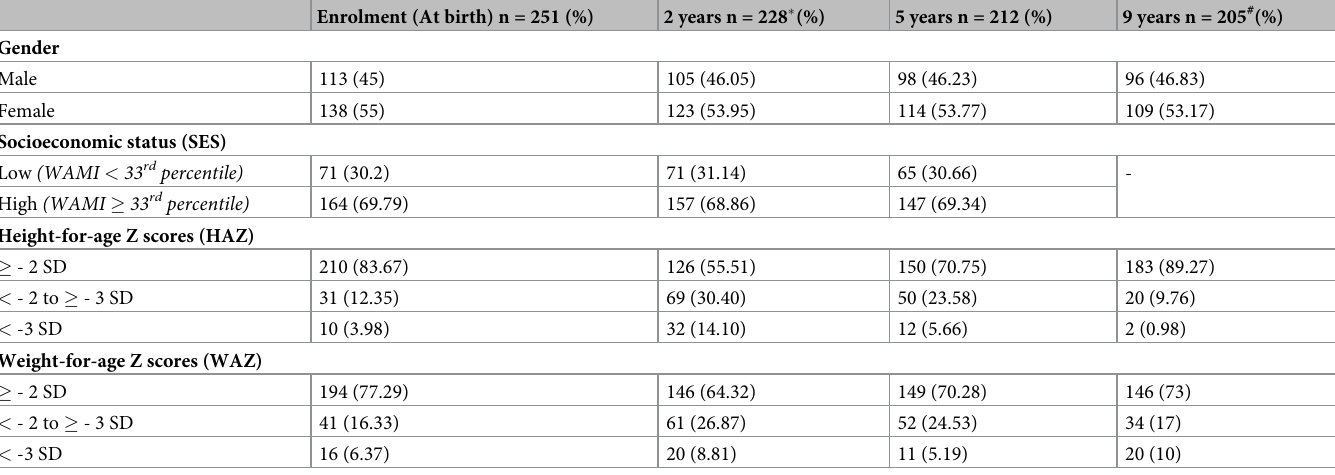
Table 1. Comparison of cohort characteristics at birth enrolment, years 2, 5 and 9 of follow-up of MAL-ED cohort.